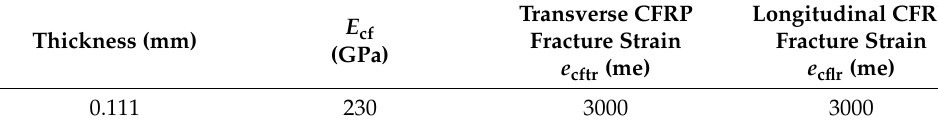
Table 4. Material properties of CFRP.